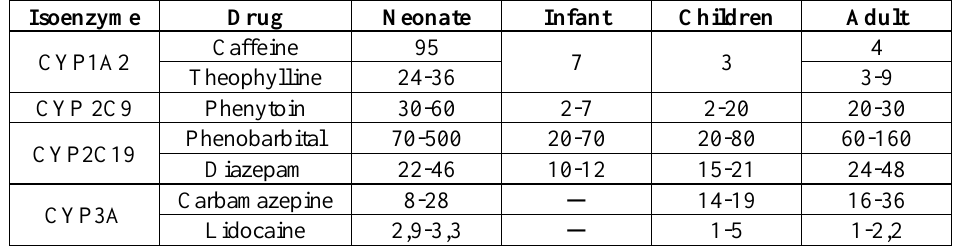
Table 2. Different half-lives (hours) between neonates, infants, children and